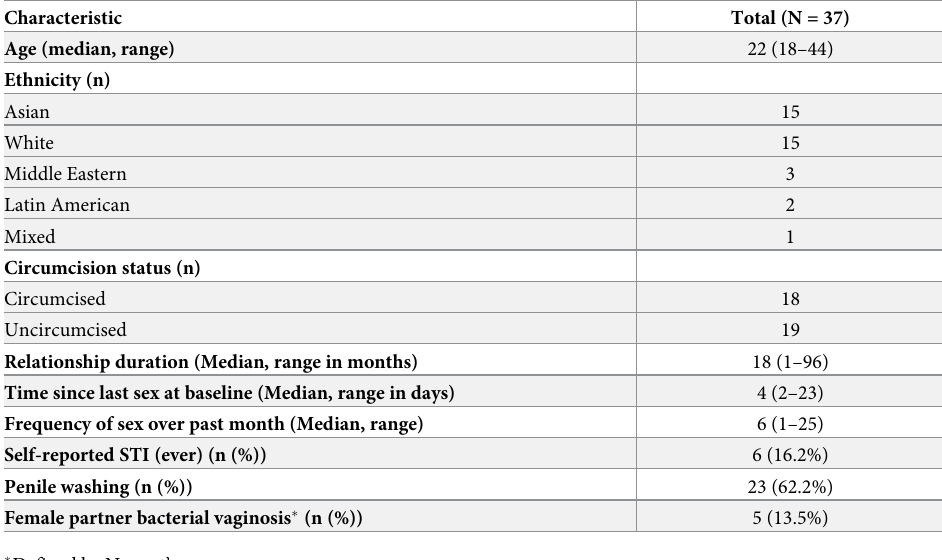
Table 1. Male participant characteristics (N = 37).